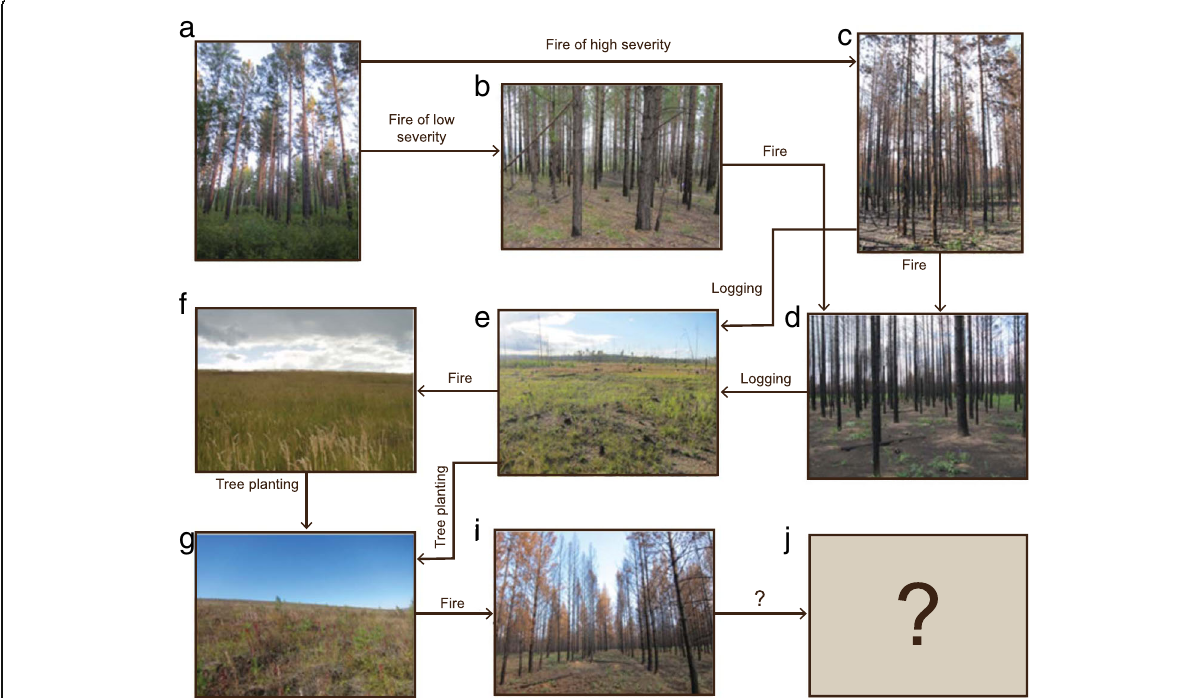
Fig. 6 Examples of fire-induced forest transformations in the light-coniferous (Scots pine and larch) forests of southern Siberia when logging and plantation are done. a Unburned forest. b Forest burned by low-severity fire with high trees survival. c Forest burned by high-severity fire with high tree mortality. d Repeatedly burned forest with all trees killed and almost all organic layer consumed. e Logging after post-fire tree mortality. f Repeatedly burned and logged forest site, with little to no tree regeneration, dominated by tall grasses. g Plantation of Scots pine on a repeatedly disturbed site with no natural regeneration. i Burned plantation. j The “ question ” mark indicates sites where management activities may alter these disturbance trajectories in unknown ways (Kukavskaya et al.